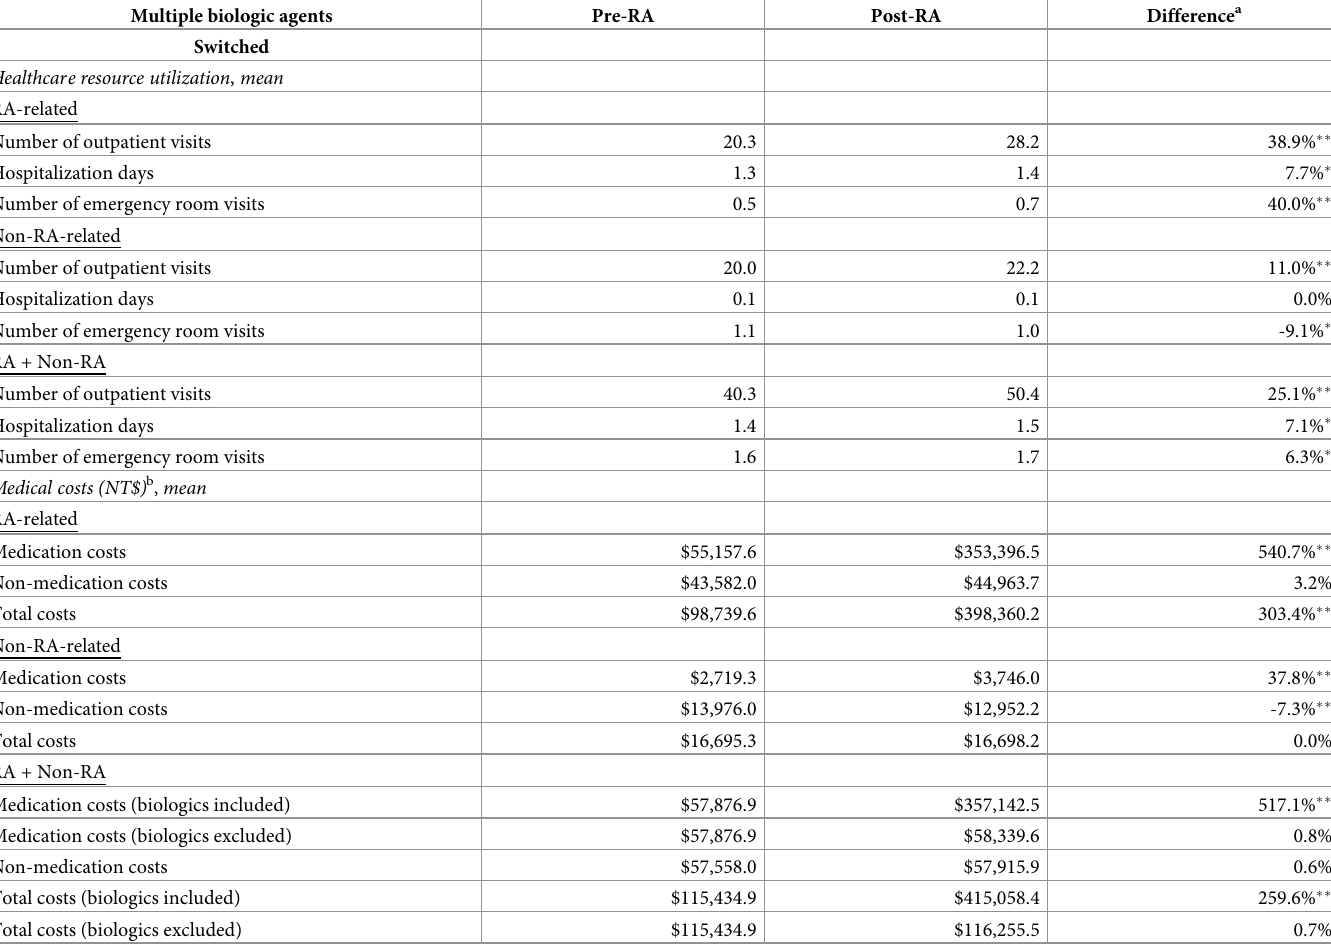
Table 4. Differences in healthcare resource utilization and direct medical costs of patients with rheumatoid arthritis (RA) before and after the use of multiple bio- logic